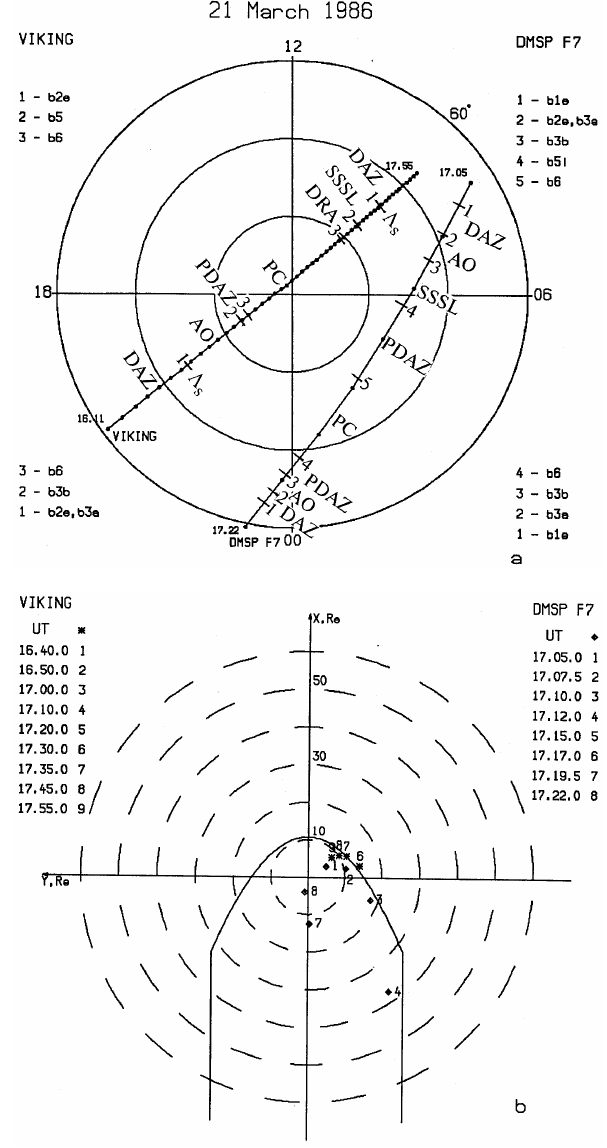
Fig. 9. The same as Fig. 1 except for the trajectories on 21 March